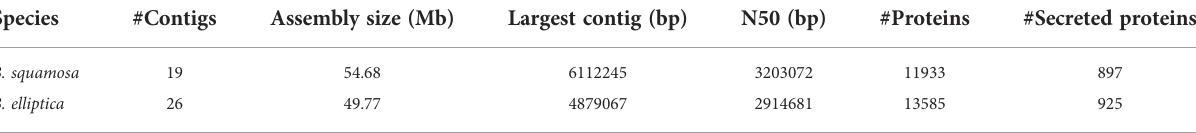
TABLE 1 Assembly information of genomes of B. elliptica and B. squamosa sequenced in this study. Species